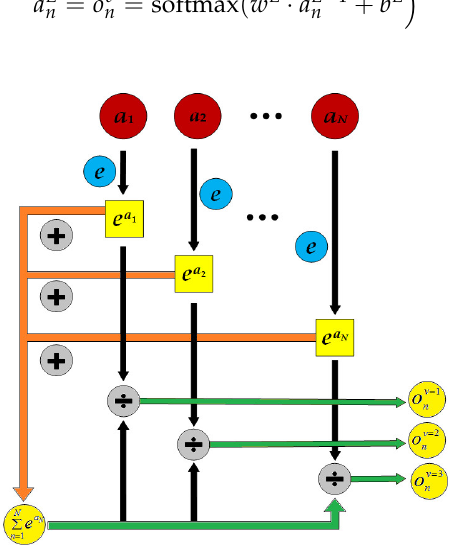
Figure 6. The classification process of softmax.